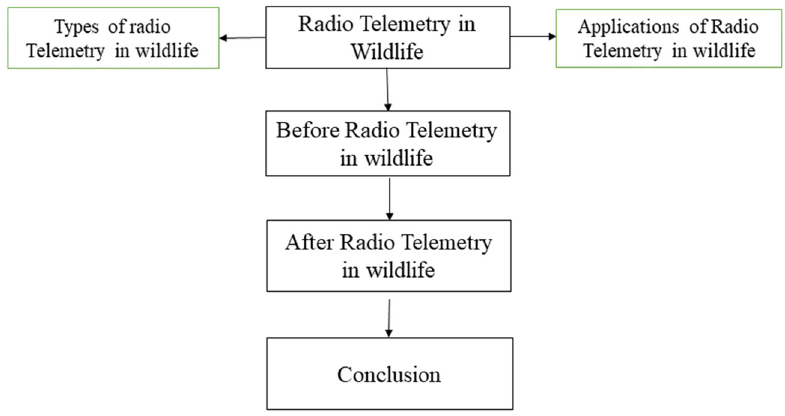
Figure 3: Flow Diagram representing the organization of review.